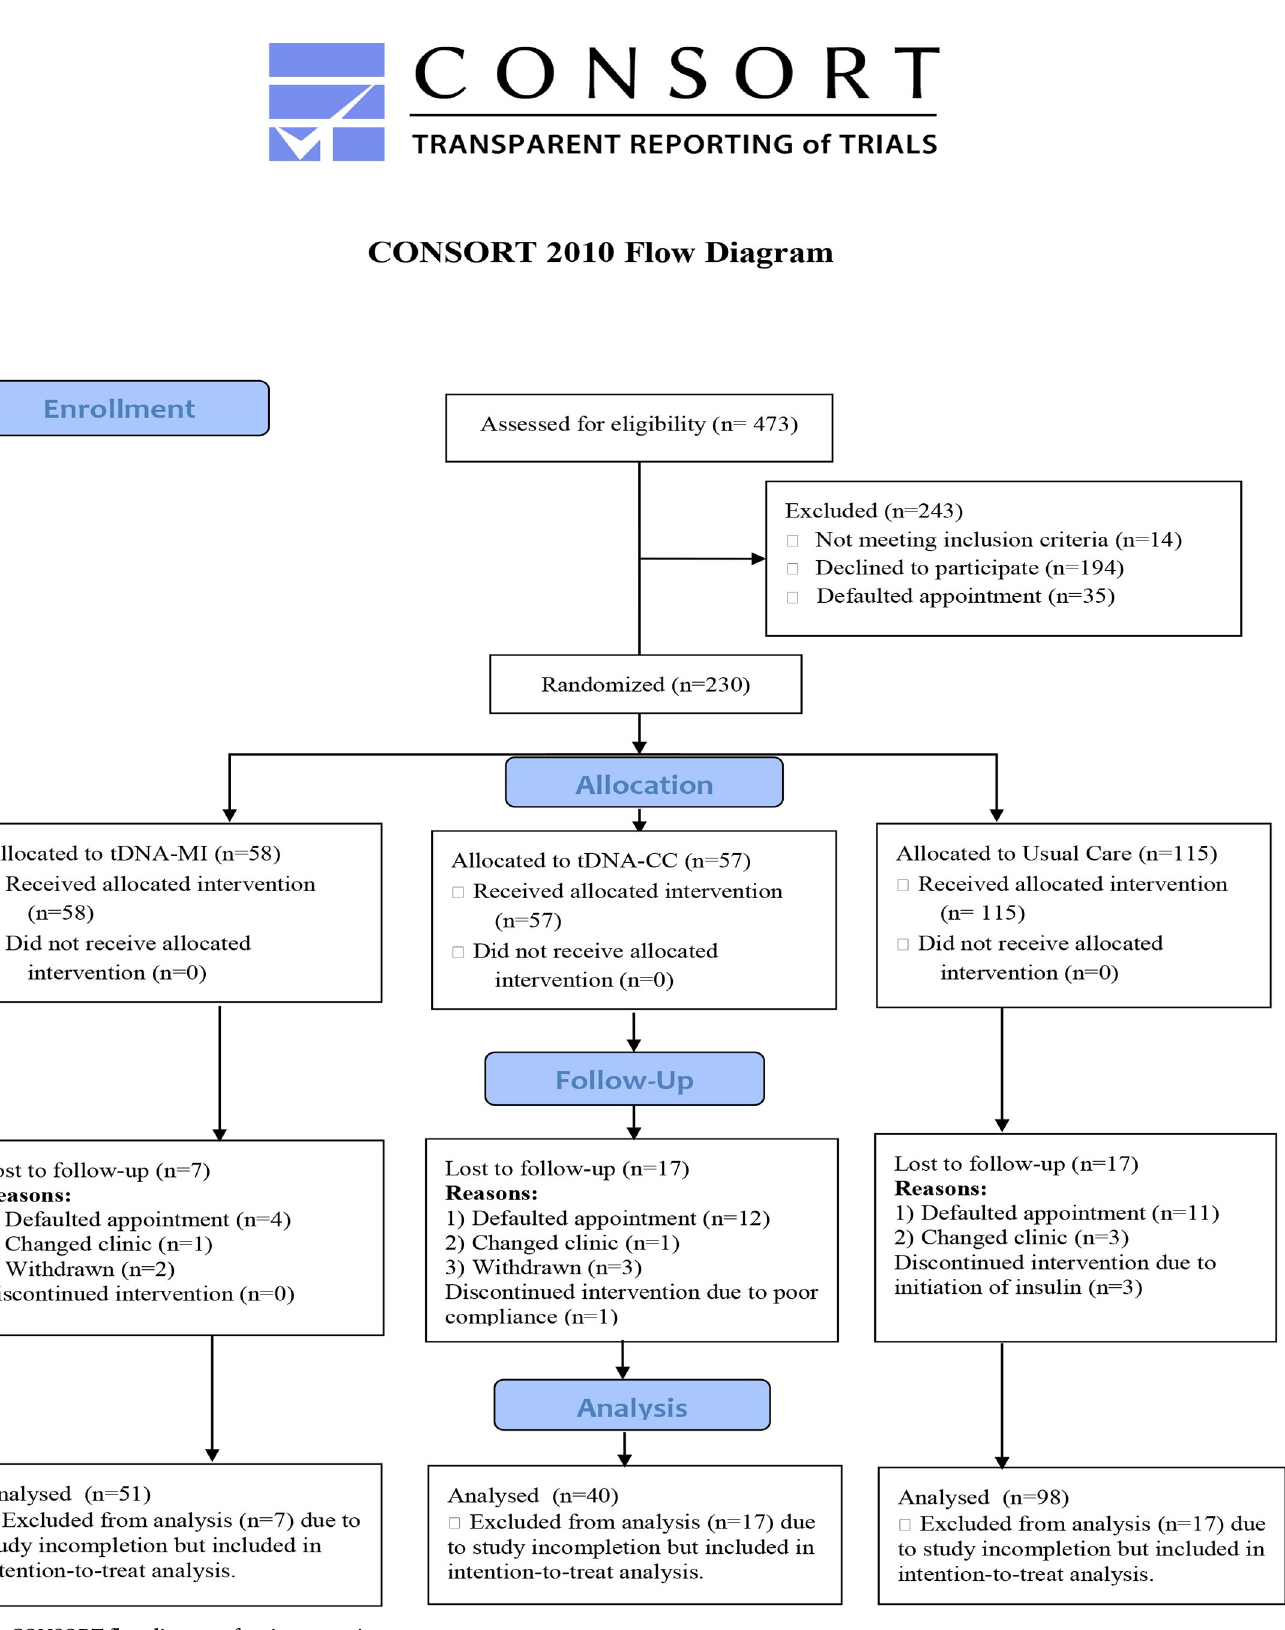
Fig 1. CONSORT flow diagram of patient retention rate. https://doi.org/10.1371/journal.pone.0242487.g001 PLOS ONE | https://doi.org/10.1371/journal.pone.0242487 November30,